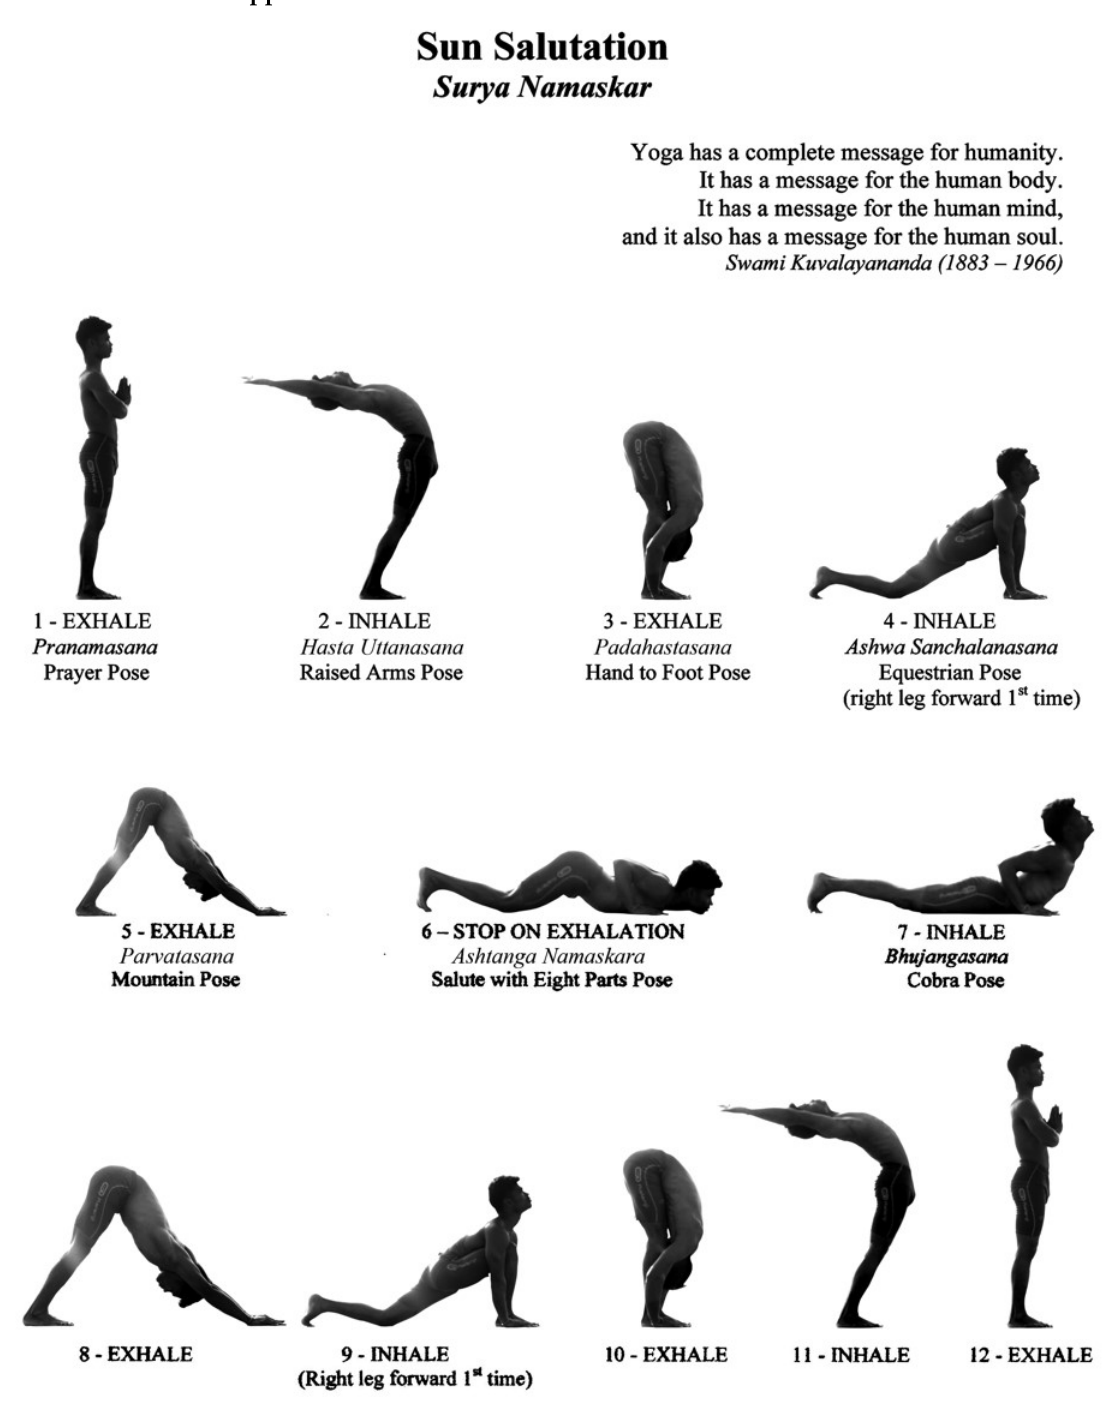
Figure A1. Sequence of asanas in the Rishikesh Series of Sun Salutations